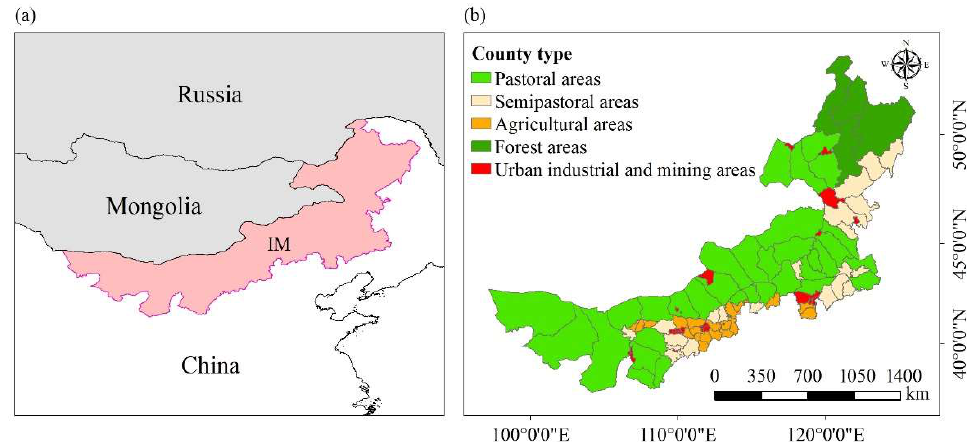
Figure 1. ( a ) Location of study area and ( b ) types of county-level administrative units in Inner Mongolia (IM).